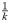
Markov on-off interrupted light model and intensity function.State 1 indicates the light is on and switching occurs with mean exponential waiting time of 1k. Photons are emitted with mean rate αx(t) with the model state x(t) ∈ {0, 1} and un-normalised intensity λ(t) ∈ {0, α}.